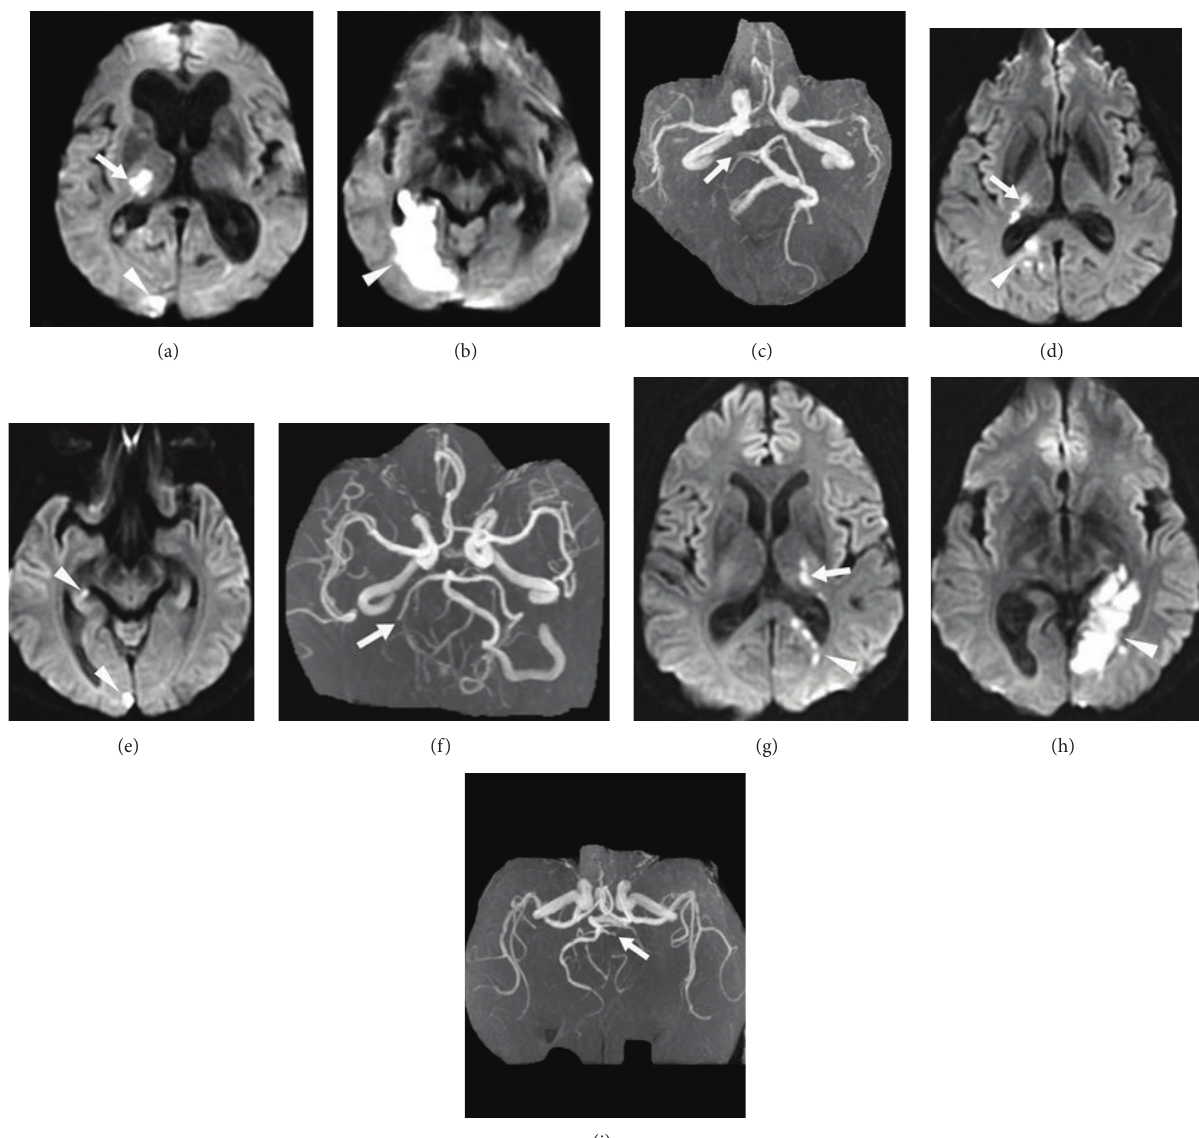
Figure 2: Thalamic infarctions in the thalamogeniculate artery territory (arrows in a, d, and g) in 3 different patients (patient 1 in a, b, and c; patient 2 in d, e, and f; patient 3 in g, h, and i) associated with other infarction areas in the ipsilateral posterior cerebral artery territories (arrowheads on a, b, d, e, g, and h) seen on DWI imaging due to posterior cerebral artery occlusion seen on TOF sequences (arrows on c, f, and